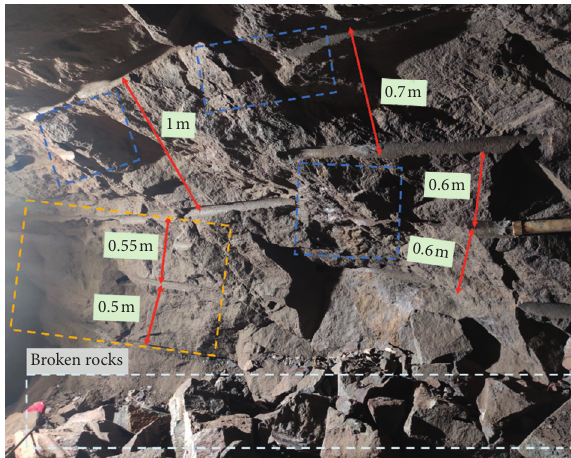
Figure 11: Effect of multiple rock fracturing.